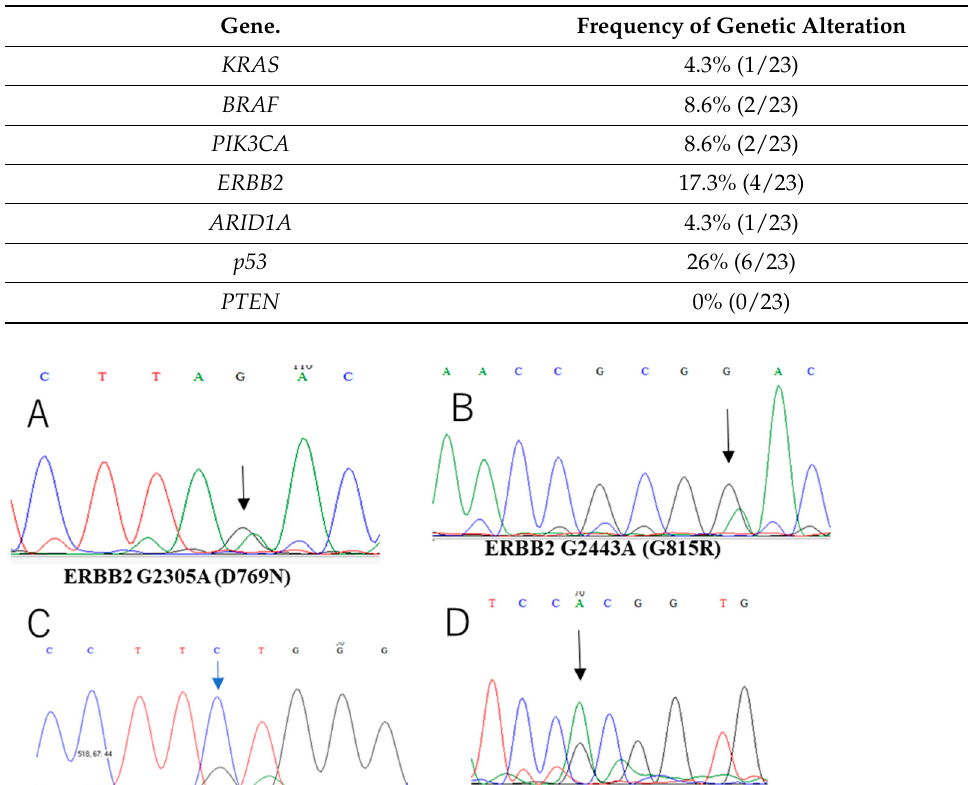
Table 3. Mutation frequency in the 23 SMBTs.